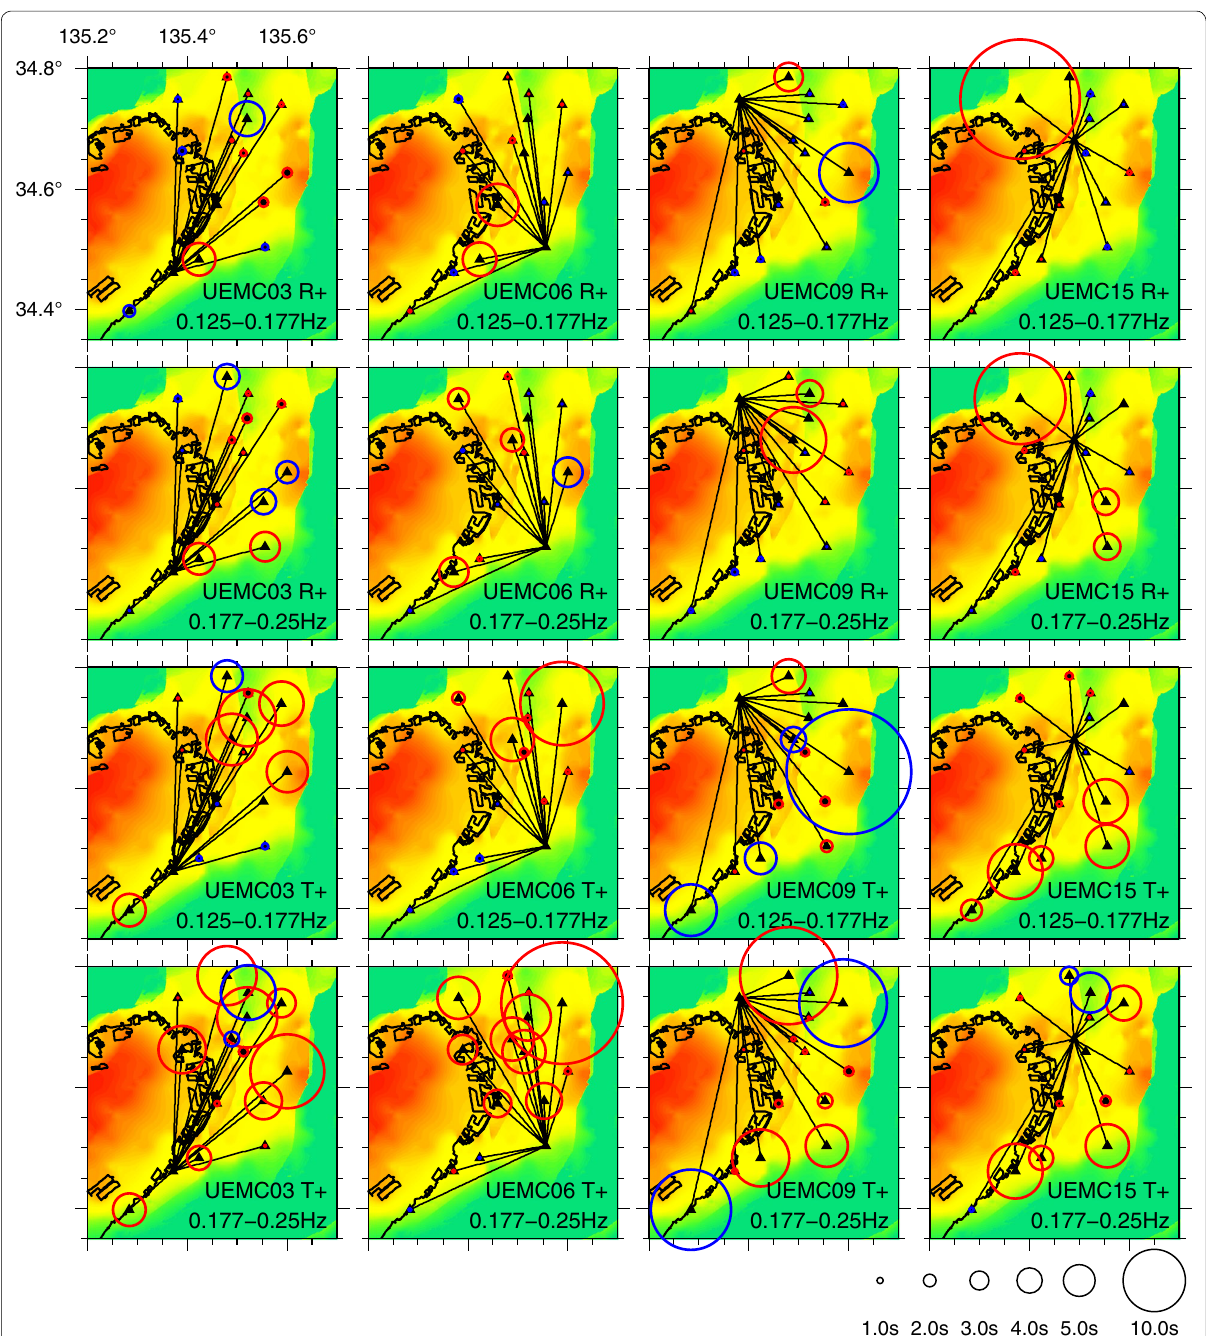
Fig. 7 Maps showing time lags between the observed and synthetic inter-station Green’s functions in two frequency ranges, 0.125–0.177 and 0.177–0.250 Hz, assuming a single force in the directions R cates that the synthetic arrives later (earlier). The radius of the circle corresponds to the amplitude of the time